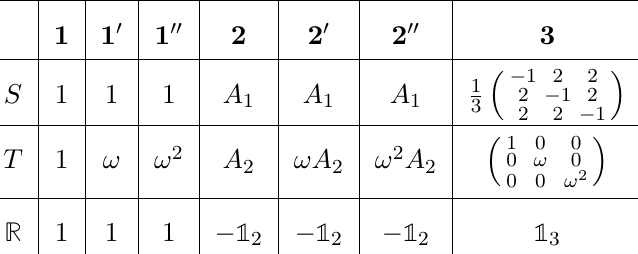
Table 3 . The representation matrices of the generators S , T and R in di(cid:11)erent irreducible repre- sentations of T 0 group, where ! = e i 2 (cid:25)= 3 = (cid:0) 1 A 1 and A 2 are given in eq. (A.3), and 1 2 and 1 3 are two-dimensional and three-dimensional unit matrices